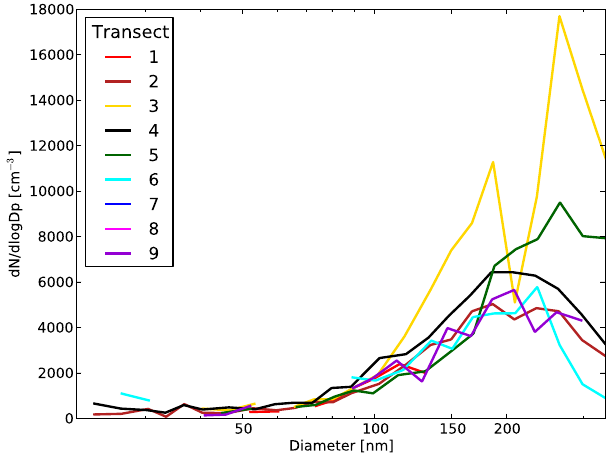
Figure 3. Median plume number–size distributions (corrected to cm − 3 at STP) divided by transect for Flight b622. All size distri- butions show a consistent accumulation mode with D pm ∼ 220nm. Size bins with less than three data points in any transect are not shown, limiting the contributions from transects 1, 7 and 8. The composite plume size distribution for both flights b622 and b623 is seen in Fig. 5.